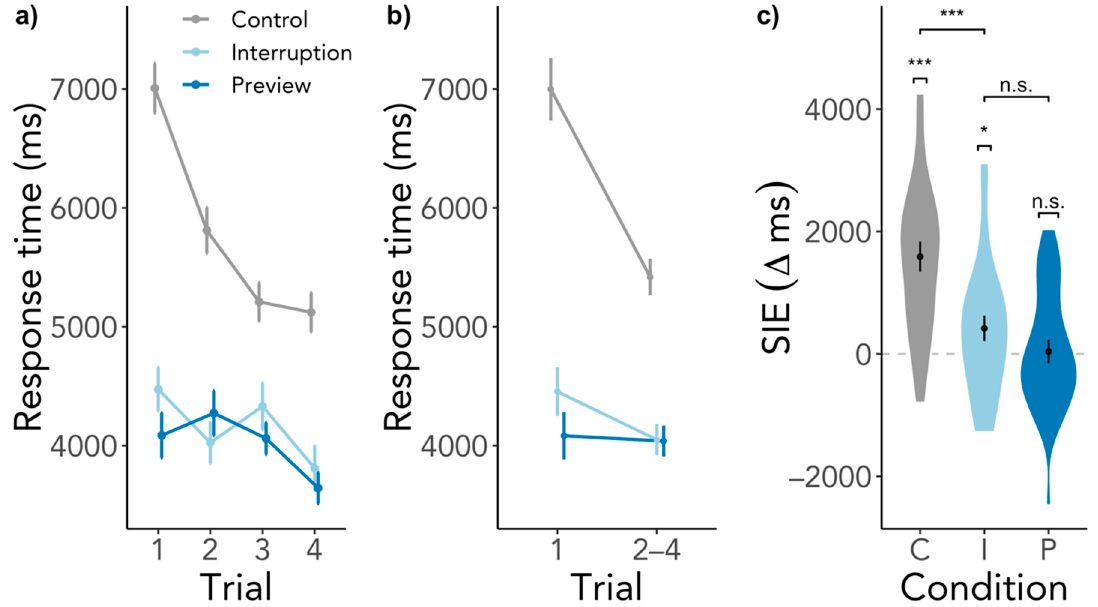
Figure 3. SIE in response times. ( a ) depicts the response times for all searches in a scene visit. ( b ) contains the same data as ( a ) but response times of the second to the fourth trial are shown as an average. ( c ) shows the difference between the response time of the first trial and the average of the second to the fourth trial. Higher values indicate a larger response time for the first trial than the subsequent trials, while the dashed line indicates the point of no difference in response times between trials. Capital letters indicate conditions, C = Control, I = Interruption, P = Preview. Error bars indicate within-subject standard error. n.s. = not significant, * p < 0.05, *** p < 0.001.